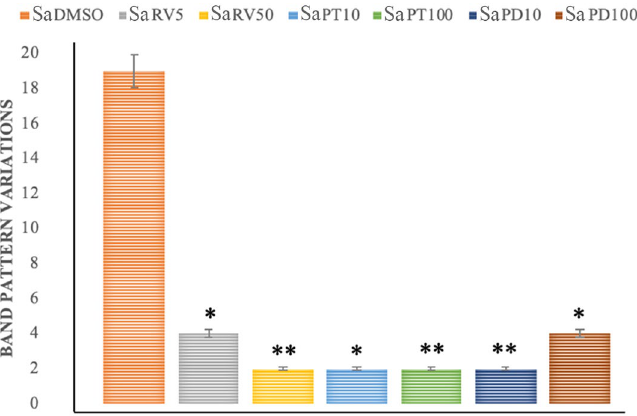
Figure 7. Representative values of band pattern variation obtained by MeSAP analysis (by two independent experiments) expressing the DNA genomic demethylation of Caco-2 cells pre-treated with SA and subsequently with each stilbenoid. (*) 0.01 < p < 0.005; (**) p < < 0.001 calculated with the χ 2 test in comparison with SA treatment.